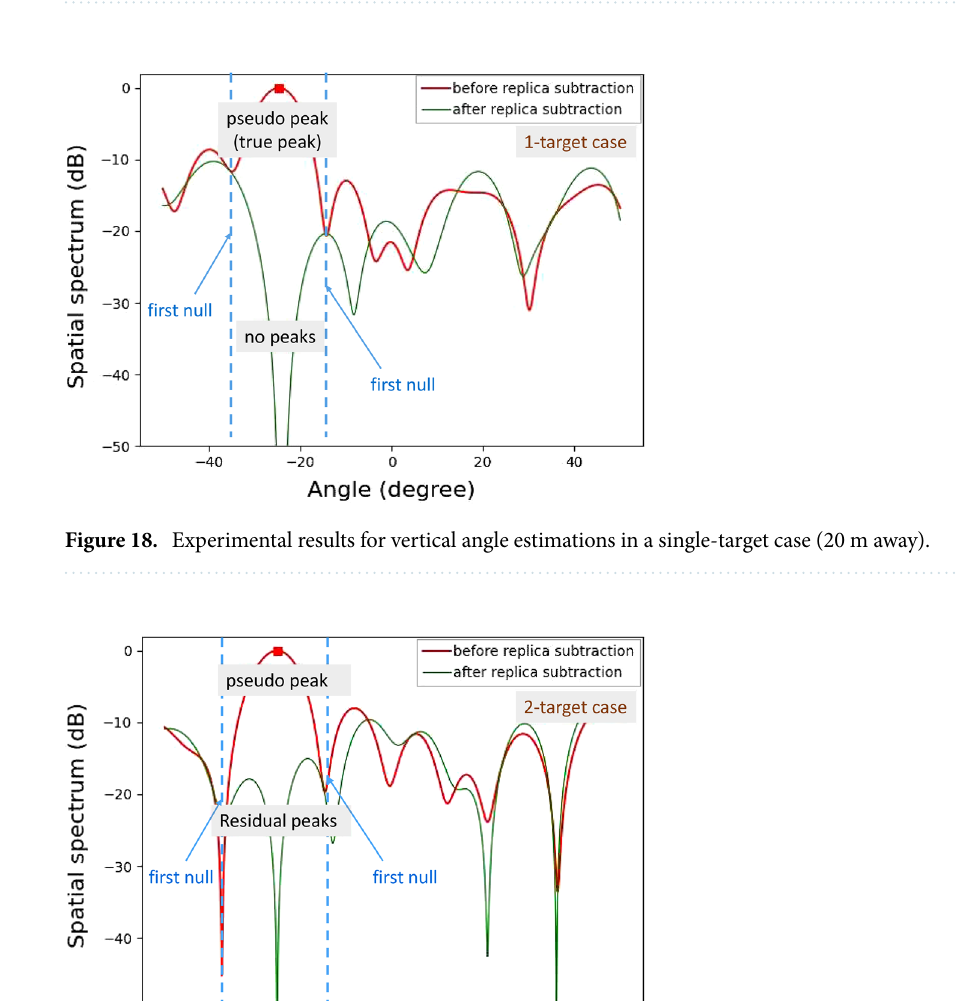
Figure 17. Experimental results for vertical angle estimations for a two-target case (3 m away with targets having the same radar cross-sectional area).